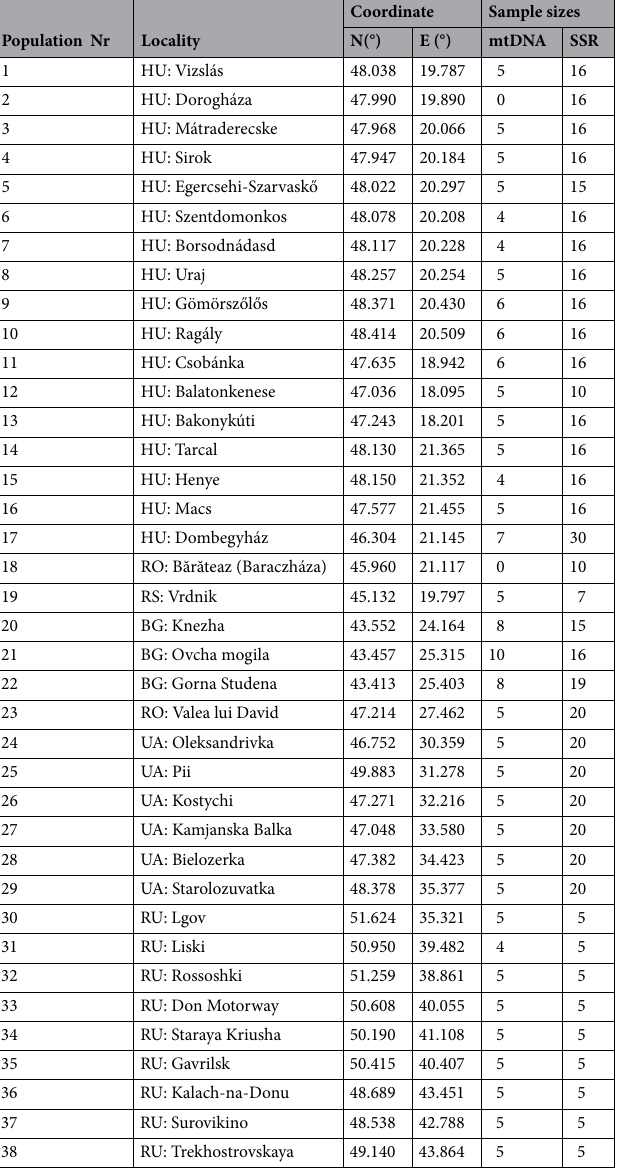
Table 1. Population number, locality information of the studied populations and number of individuals included in the mitochondrial (mtDNA) and microsatellite (SSR) datasets. Country codes follow ISO